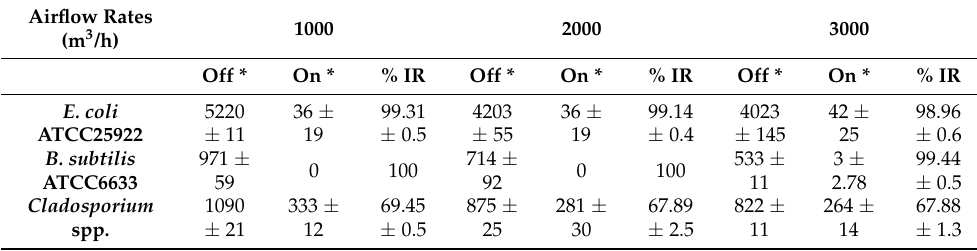
Table 1. Microbial concentrations (CFU/m 3 ± SD, average of three determinations) in air sampled downstream of the sanitation system in the test rig, measured at 1000–2000–3000 m 3 /h (ISO, 2019). Inactivation percentages (% IR ± SD) are